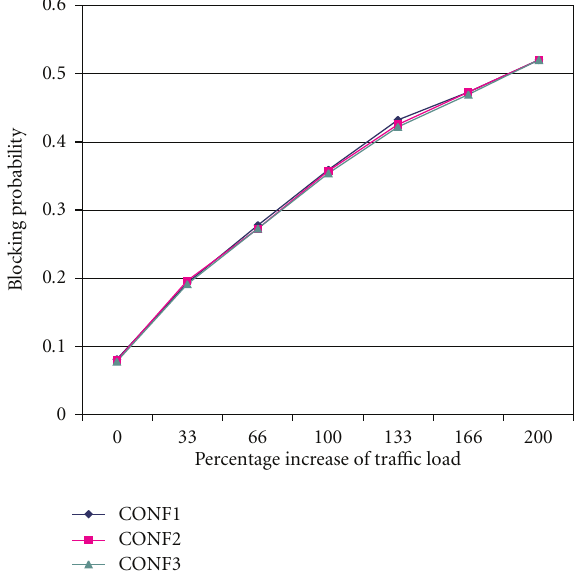
Figure 8: Performances with reassignment for ratio 21:49. (1) The topological model is a group of 49 hexagonal cells that form a parallelogram shape, as shown in the Figure 4. (2) The total number of channels for the network is 70, distributed in FC and DC, that is, | FC ∪ DC | = 70. A channel serves one call at most. In FCA, the available fixed channels are distributed among the cells, while in DCA, all dynamic channels are put in a central pool. A channel is assigned to an incoming call by a central controller that monitors the whole cellular network. (3) Incoming calls at each cell may be served by any of the available